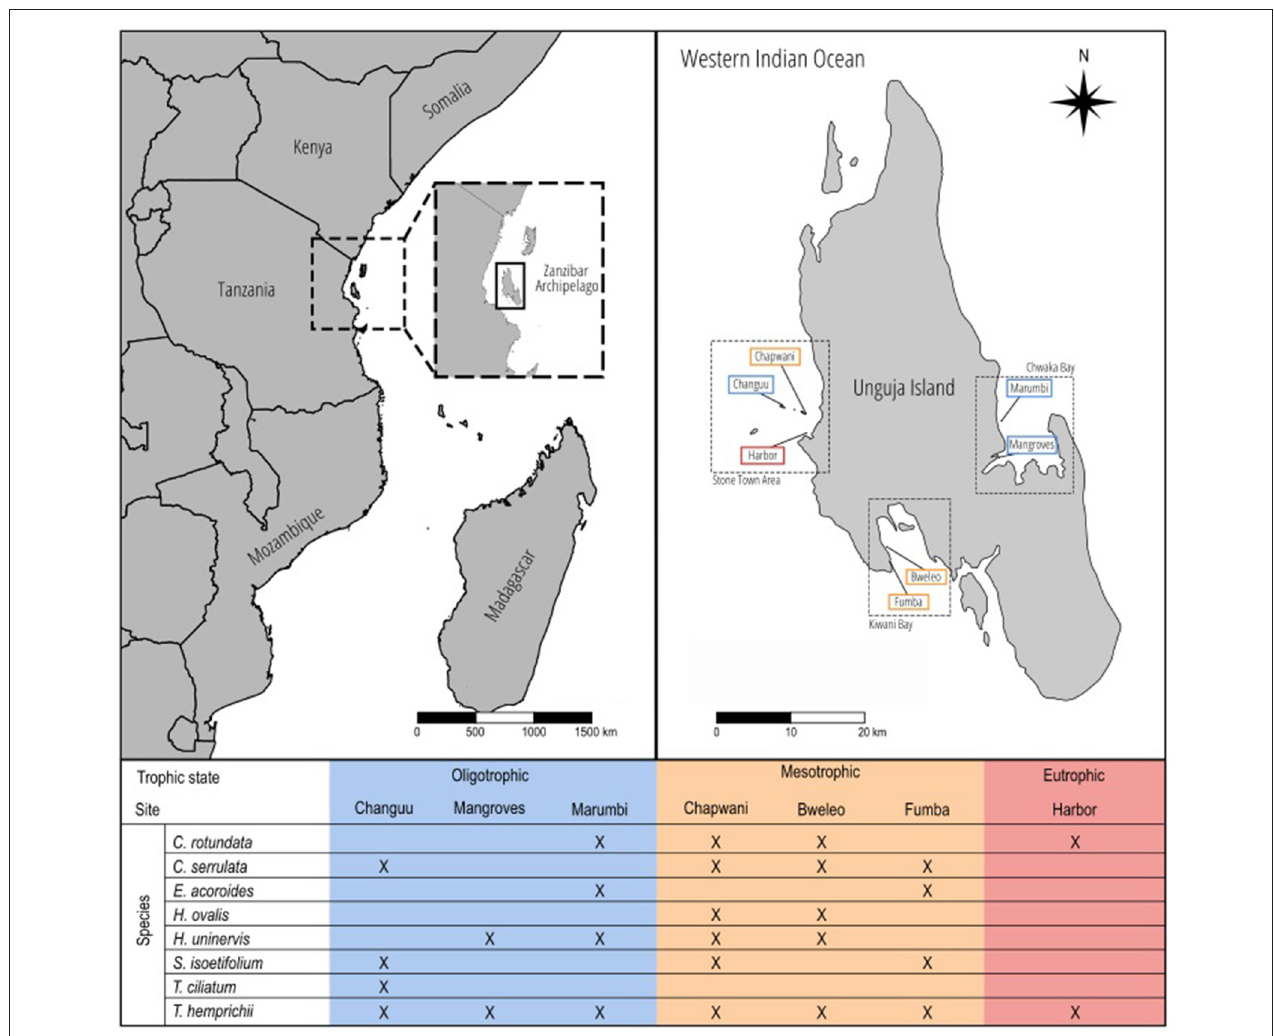
FIGURE 1 | Map of the study area. On the top left, an overview of the Eastern African coast, where the Zanzibar Archipelago is located. On the top right, Unguja Island and the seven sites selected in three different areas around the island. The colors indicate the trophic state to which they were assigned. The bottom table indicates which seagrass species were present in which